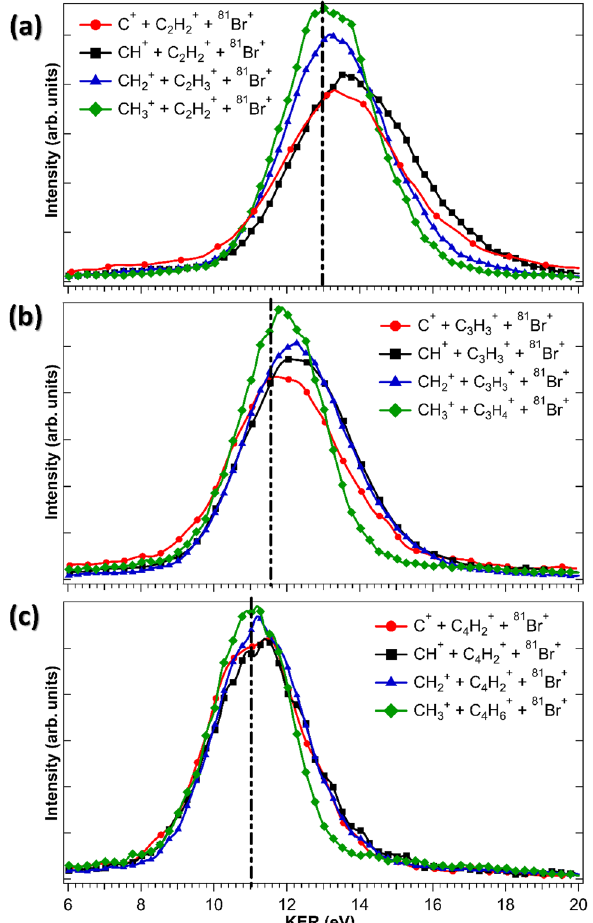
Figure 5. Comparison of the KER distributions for different fragmentation channels in ( a ) BCpro, ( b ) BCbut, and ( c ) BCpen. All distributions are normalized to have equal integral yield. The vertical black dash-dotted lines show the values obtained from Coulomb explosion simulations (see